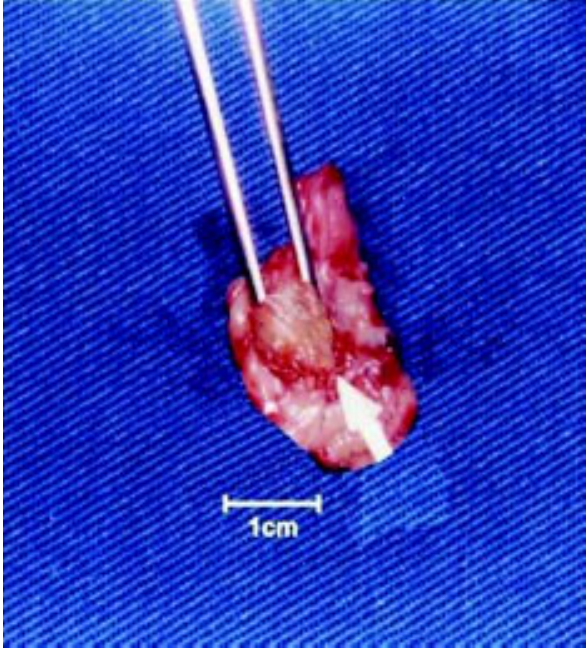
Fig. 1 - Fifteen days follow-up: aortic porcine cusp (arrow) glutaraldheyde preserved implanted in the infrarenal vena cava (dog